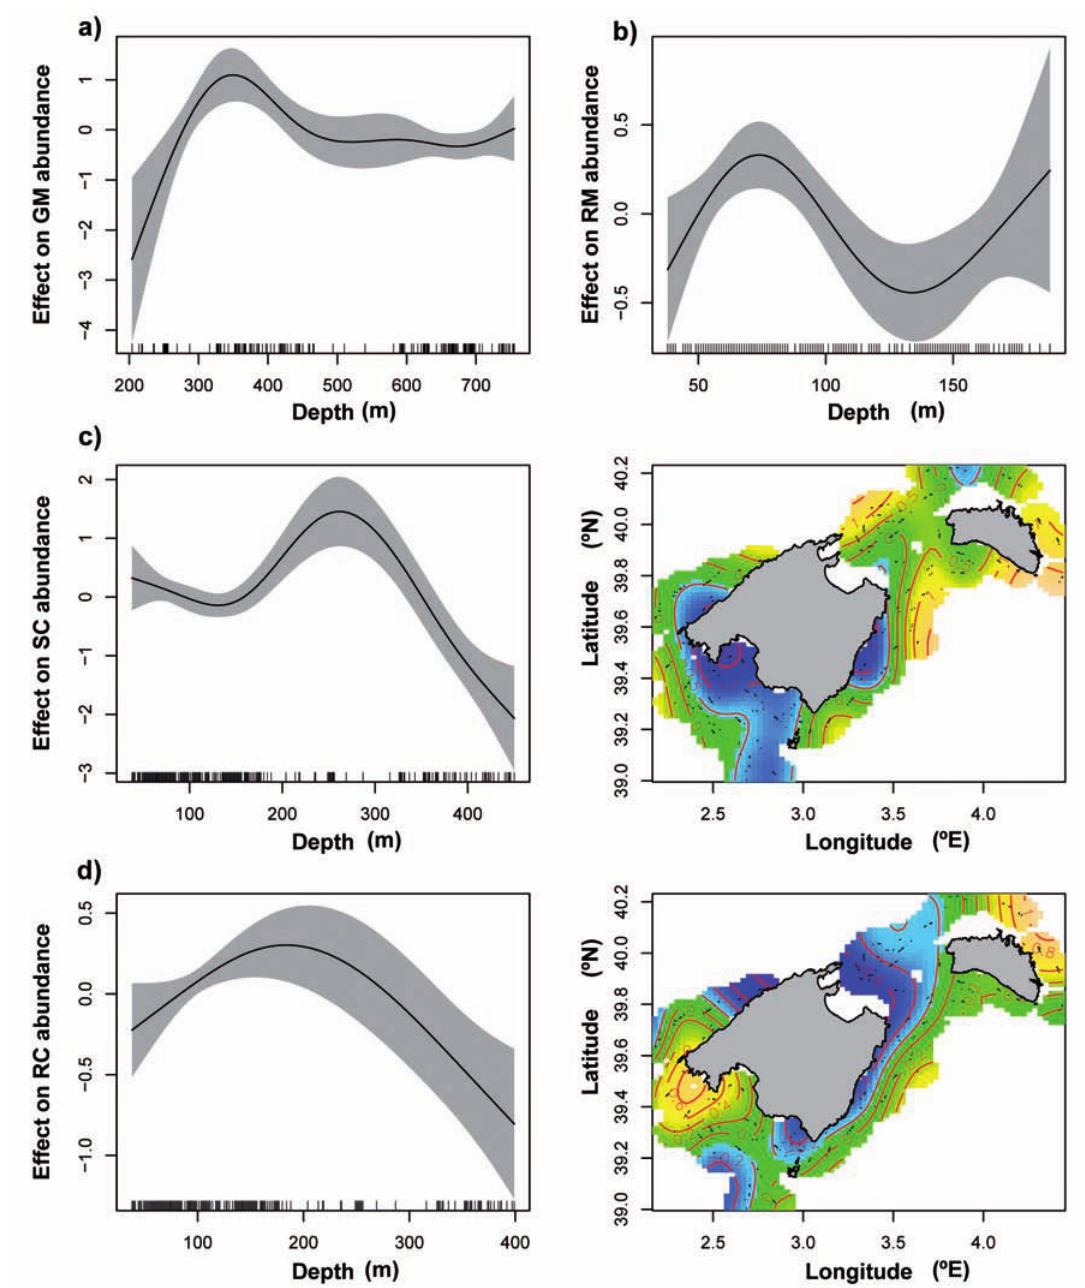
Fig . 4. – The partial effects of bottom depth and geographic position on G. melastomus (a), R. miraletus (b), S. canicula (c) and R. clavata (d) abundance, estimated from the generalized additive model. For the position plot, orange indicates high predicted values, green medium values and blue indicates low values. Shaded areas on the depth plot are 95% confidence intervals, and tick marks on the x -axes of the depth plots indicate sampling intensity. Only those maps resulting from significant models were included. Note that the x -axes for the plots representing the bathymetric distribution are different in order to take into account the distribution ranges of the